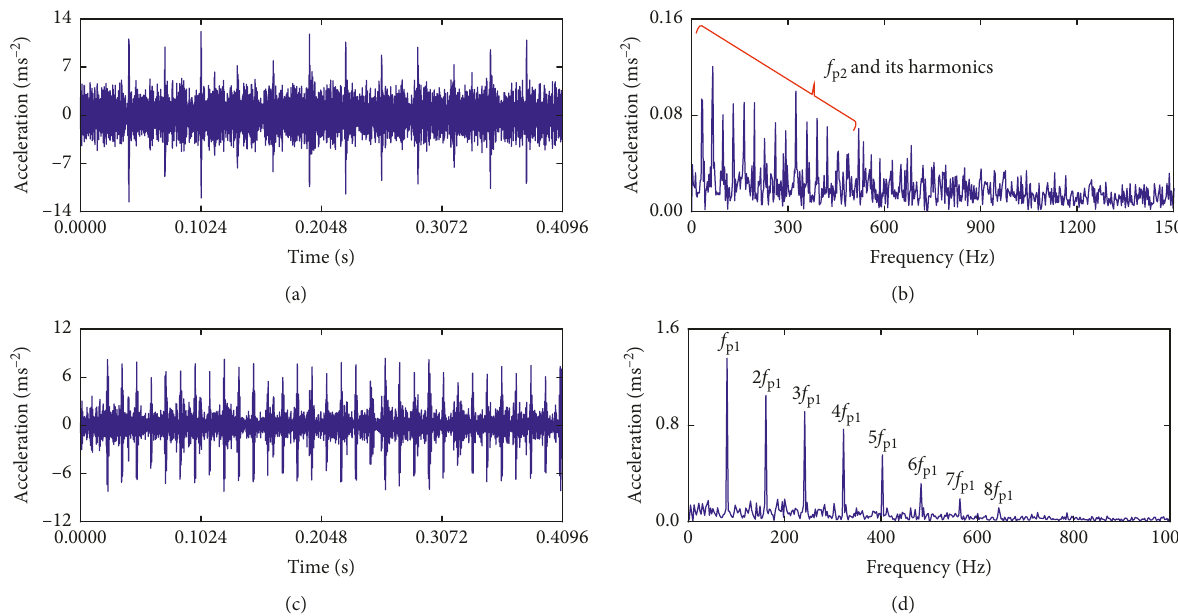
Figure 20: Processing results obtained using EEMD: (a) IMF1; (b) envelope spectra of IMF1; (c) IMF2; (d) envelope spectra of IMF2.